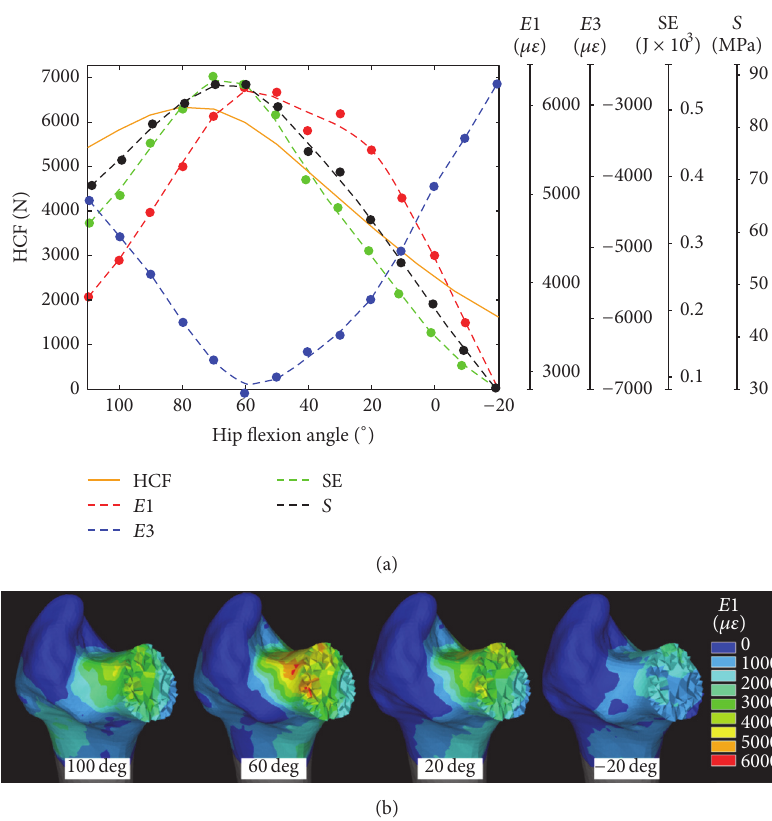
Figure 4: (a) The magnitude of the hip contact force (HCF), the peak tensile strain ( E 1), compressive strain ( E 3), strain energy (SE), and von Mises stress ( S ) over the studied range of hip flexion angles. (b) The tensile strain distribution in the proximal femur.